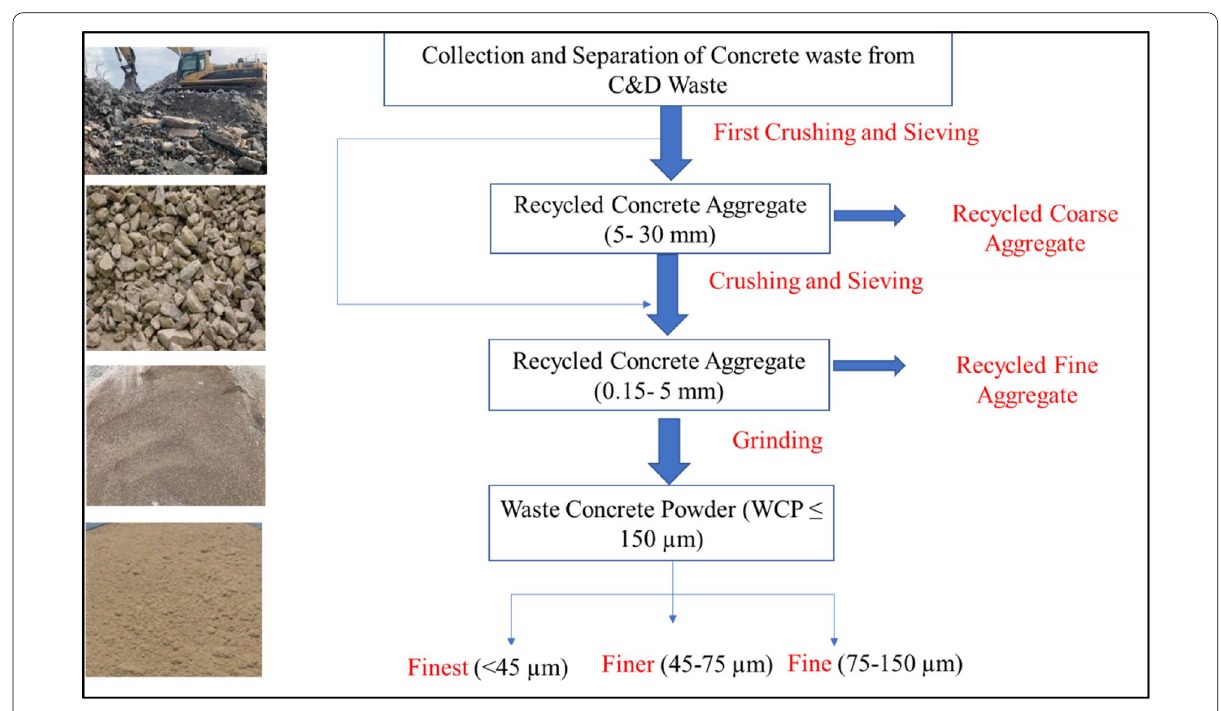
Fig. 2 WCP generation process.